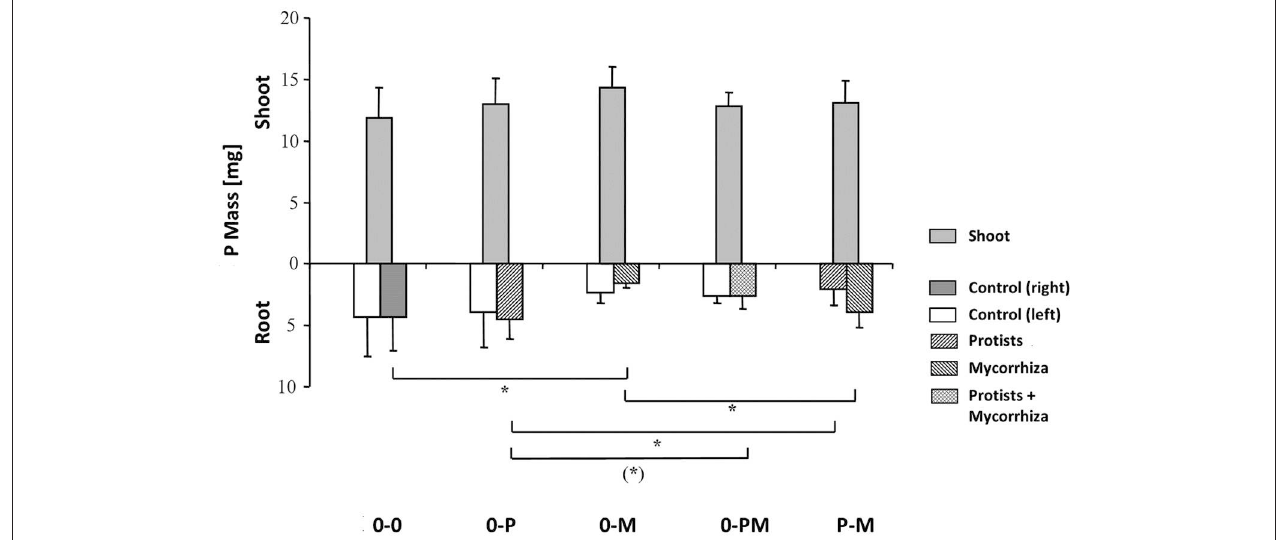
FIGURE 3 | Total P mass (mg) of shoots and of roots in both root chambers in control plants (0-0), plants treated with protists in the right root chamber (0-P), or treated with mycorrhiza in the right root chamber (0-M), or treated with protists and mycorrhiza together in the right root chamber (0-PM), or where the left and right root chambers were separately treated with protists and mycorrhiza (P-M). Means and standard deviation; horizontal lines denote significant contrasts with (*) p < 0.1, * p < 0.05.